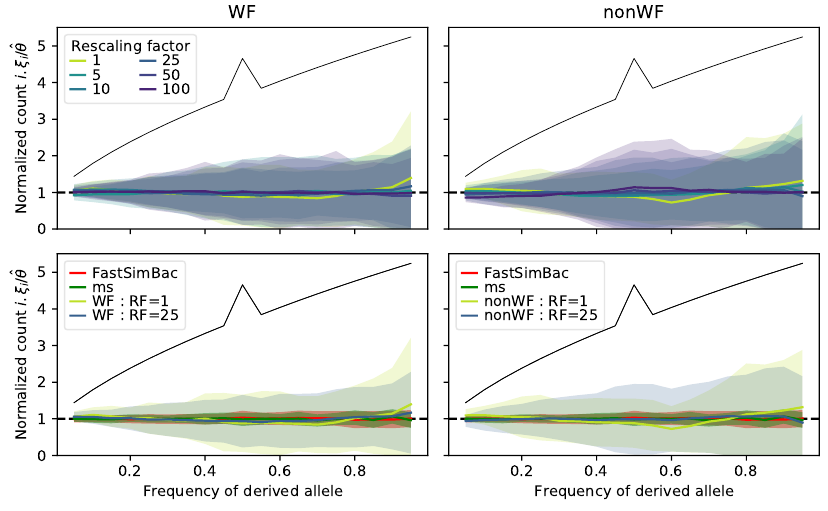
Figure 2 – Normalized Site Frequency Spectrum (SFS) for four simulators and different rescaling factors. The left panels represent the SFS of the WF simulations under different rescaling factors (top left) and compared to the coalescent simulators (bottom left). The same information is shown on the right-hand side of the figure, but for the nonWF sim- ulations. The colored shaded areas represent one standard deviation (mean std). The ± horizontal dashed line at 1 indicates the expected average value and the black line the expected standard deviation, both under the WF model without recombination. Param- 10 − 9 ; Ne = 140k; 20000 generations. eters used: chromosome size: 2Mb; µ = ρ = 1 . 53 × Rescaling does not affect the shape of the SFS and it matches that of the expected hori- zontal line at 1, is not different across rescaling factors, and is similar to the SFS obtained with the coalescent